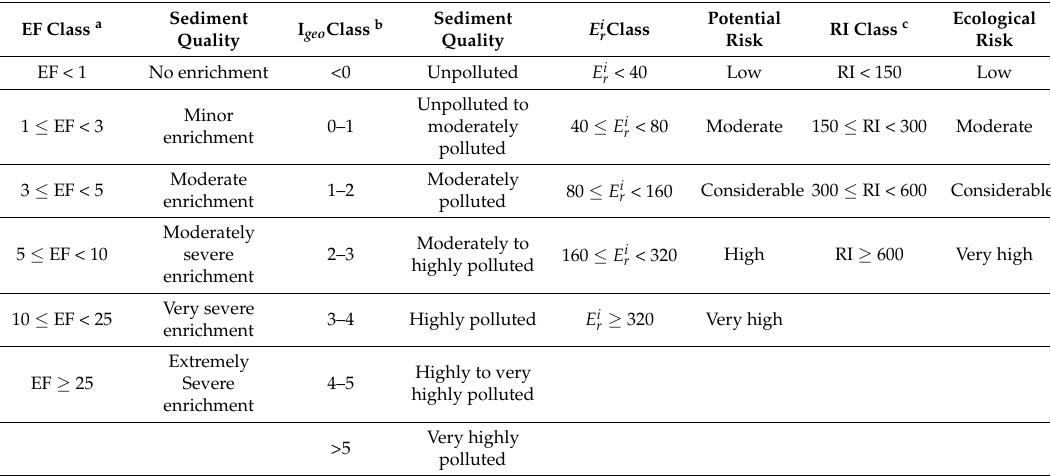
Table 1. The enrichment factor (EF), geo-accumulation index (I geo ), and risk index (RI) classes in relation to sediment